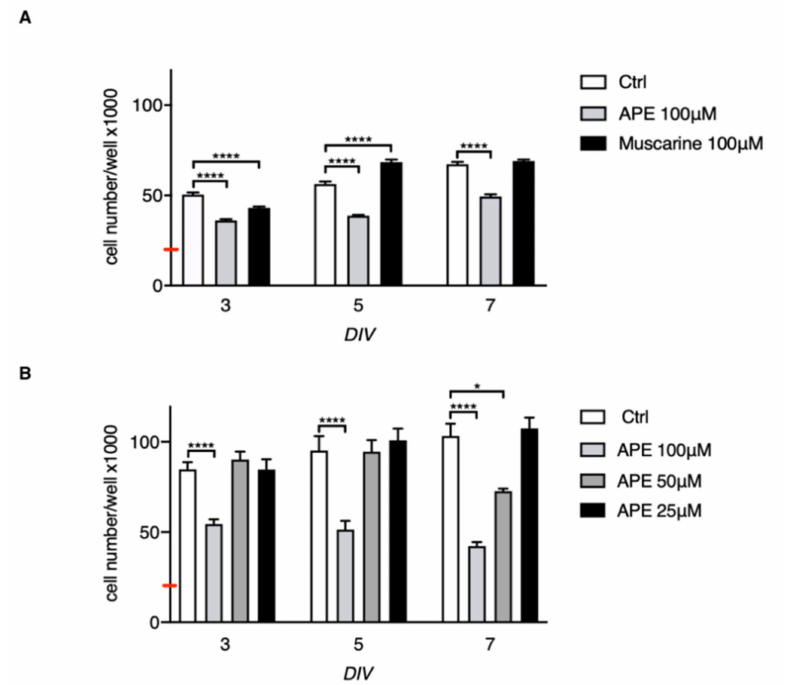
Figure 2. MTS assay in hSCs maintained up to 7 days of treatment in vitro (DIV) in presence or absence of muscarinic agonists. ( A ) APE (100 µ M) exposure was able to decrease cell growth up to 7 days of treatment (**** p < 0.0001; APE vs. ctrl at the same time point). The treatment with 100 µ M muscarine appeared to promote cell proliferation after 5 days of treatment (**** p < 0.0001; muscarine vs. ctrl at the same time point). Data are represented as mean ± SEM of three independent experiments performed in triplicate in five di ff erent patients. One-way ANOVA with Tukey’s post hoc test between di ff erent time points is reported in the Supplementary Materials. ( B ) hSCs cell growth was also evaluated at di ff erent APE concentrations (25, 50, and 100 µ M) at 3, 5, and 7 DIV. ANOVA with Dunnett multiple comparison analyses was performed against control at the same time point. Data are represented as mean ± SEM of three independent experiments performed in triplicate in five di ff erent patients (**** p < 0.0001; * p < 0.05). The red bar represents the number of cells plated (20 × 10 3 cells / well). The day after plating, cells were treated with both muscarinic agonists at the final concentration of 100 µ M ( A ) or with di ff erent concentrations of APE ( B ); MTS assays were performed after 3, 5, and 7 days of